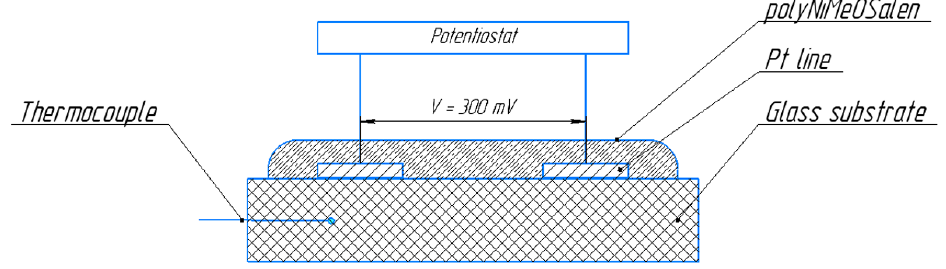
Figure 2. The wiring diagram of the potentiostat and thermocouple for temperature testing.